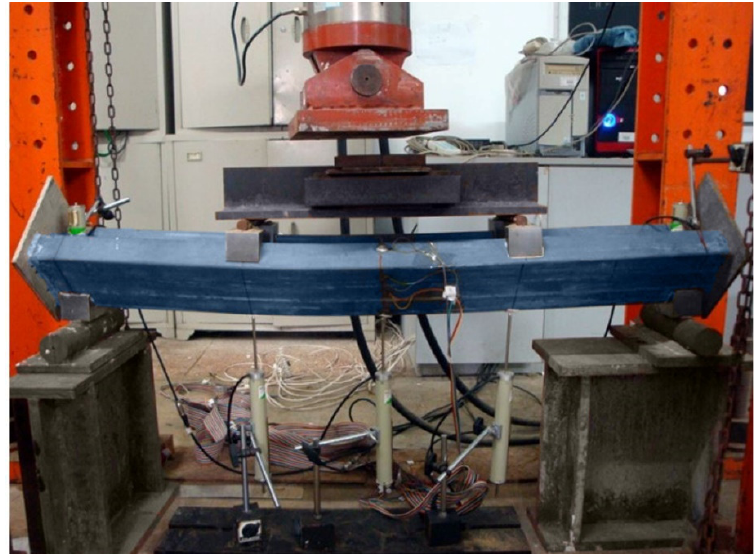
Figure 10. Cross-section corresponding to loading points and supports: ( a ) Load at the heel; ( b ) Load at the toes.